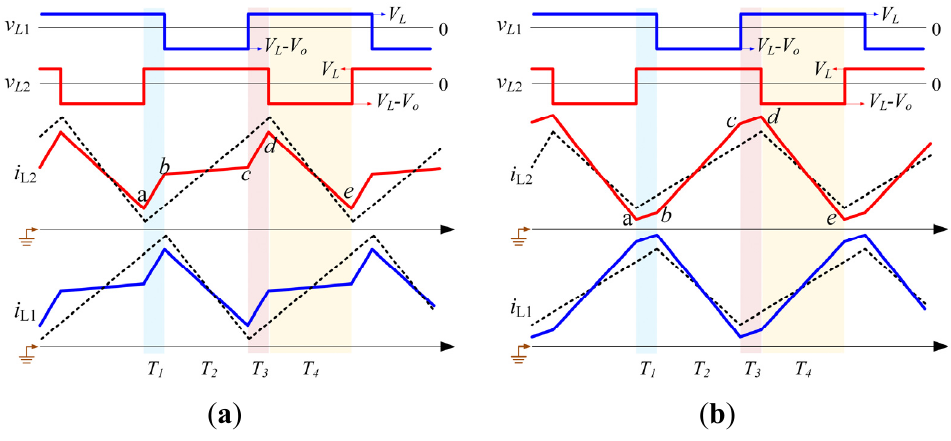
Figure 6. Current curves when duty cycle is larger than 0.5 ( a ) Inverse coupling, ( b ) Direct